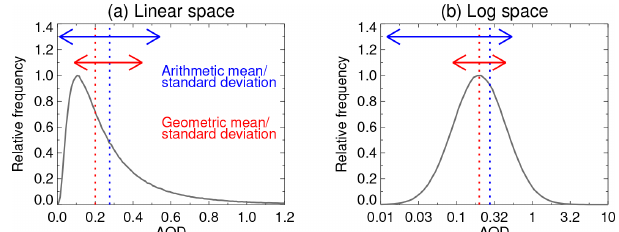
Figure 1. Synthetic frequency distributions for log-normally dis- tributed AOD with a mean of 0.2 and geometric standard deviation 0.35, L ( 0 . 2 , 0 . 35 2 ) , shown on (a) linear and (b) logarithmic AOD axes. Vertical red and blue dashed lines represent geometric- and arithmetic-mean values, respectively. Horizontal red and blue ar- rows indicate the range of geometric and arithmetic mean ± one standard deviation.